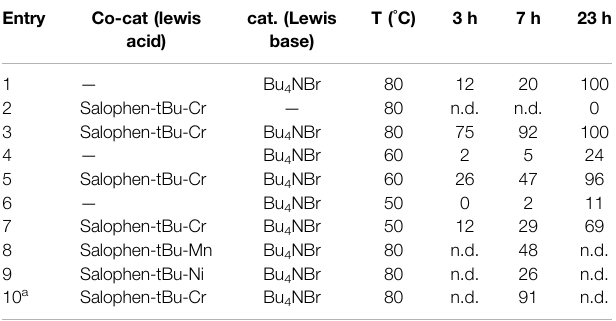
Thus, at the highest reaction temperature tested (80 ° C), Bu 4 NBr